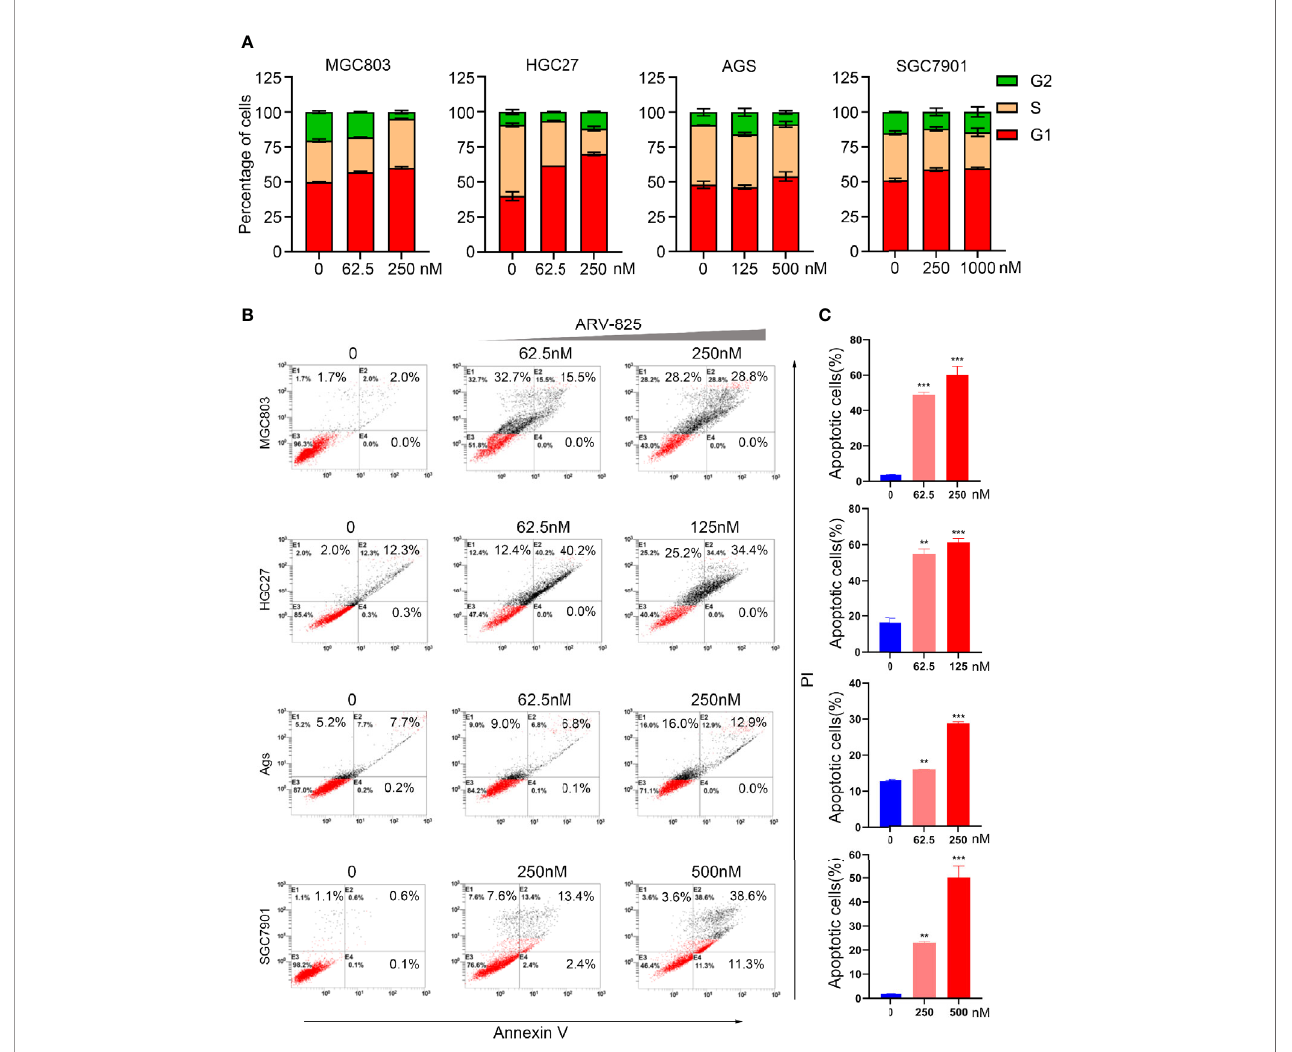
FIGURE 5 | ARV-825 induces cell cycle block and apoptosis of gastric cancer cells. (A) ARV-825 increased ratio of G1 phase cells and simultaneously decreased the ratio of S phase and G2 phase cells in MGC803, HGC27, AGS, and SGC7901 cells via cell cycle analysis. (B) The ratio of apoptotic cells among gastric cancer cells increased dose dependently after treated with ARV-825 via cell apoptosis analysis. (C) The ratio of apoptotic cells markedly elevated dose dependently in gastric cancer cells with ARV-825 treatment. ** p < 0.01, *** p <